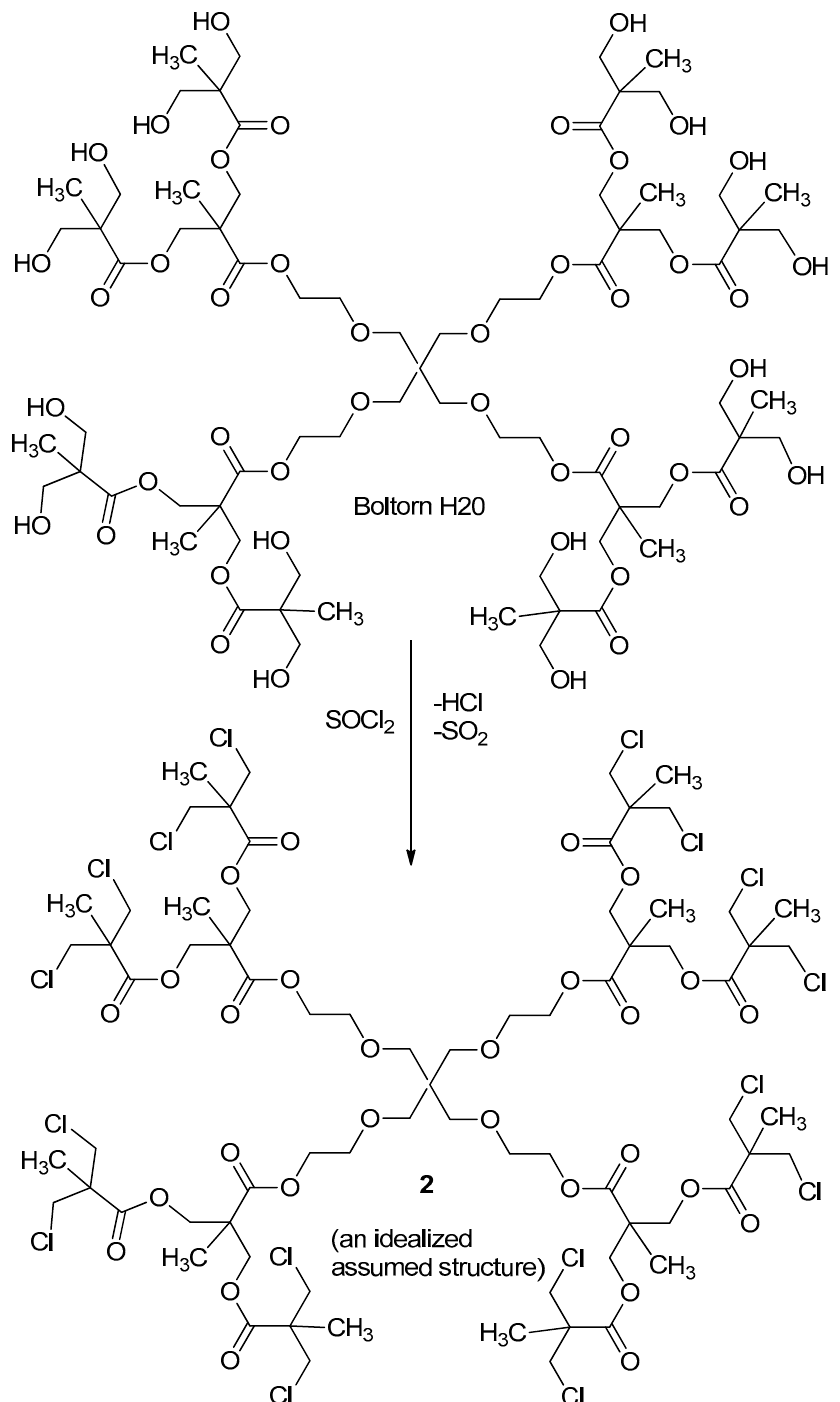
Scheme 1. The Reaction of Boltorn H20 with thionyl